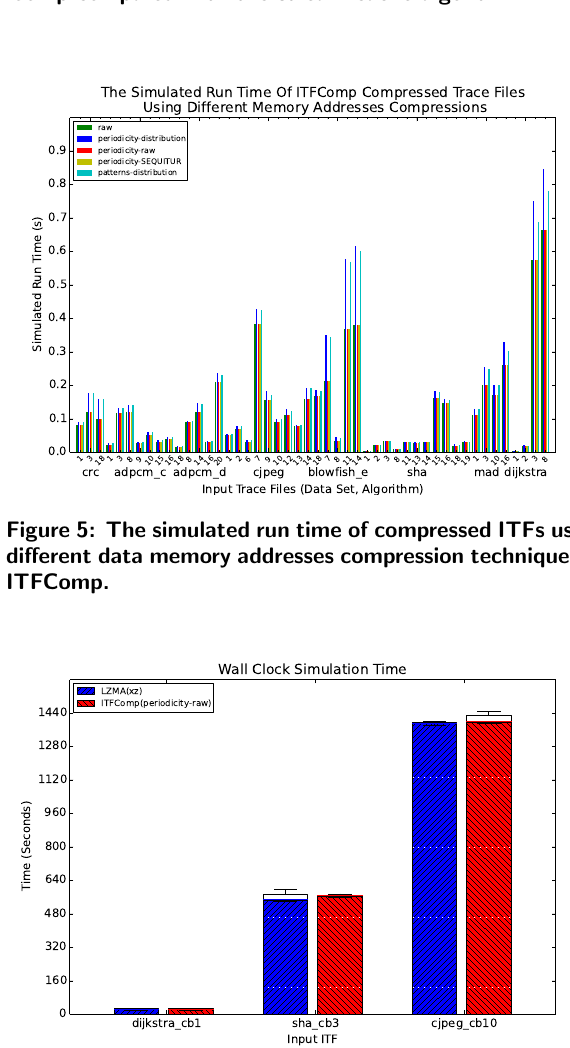
Table 3: The average compression ratio achieved by ITFComp compared with the stream cache algorithm.